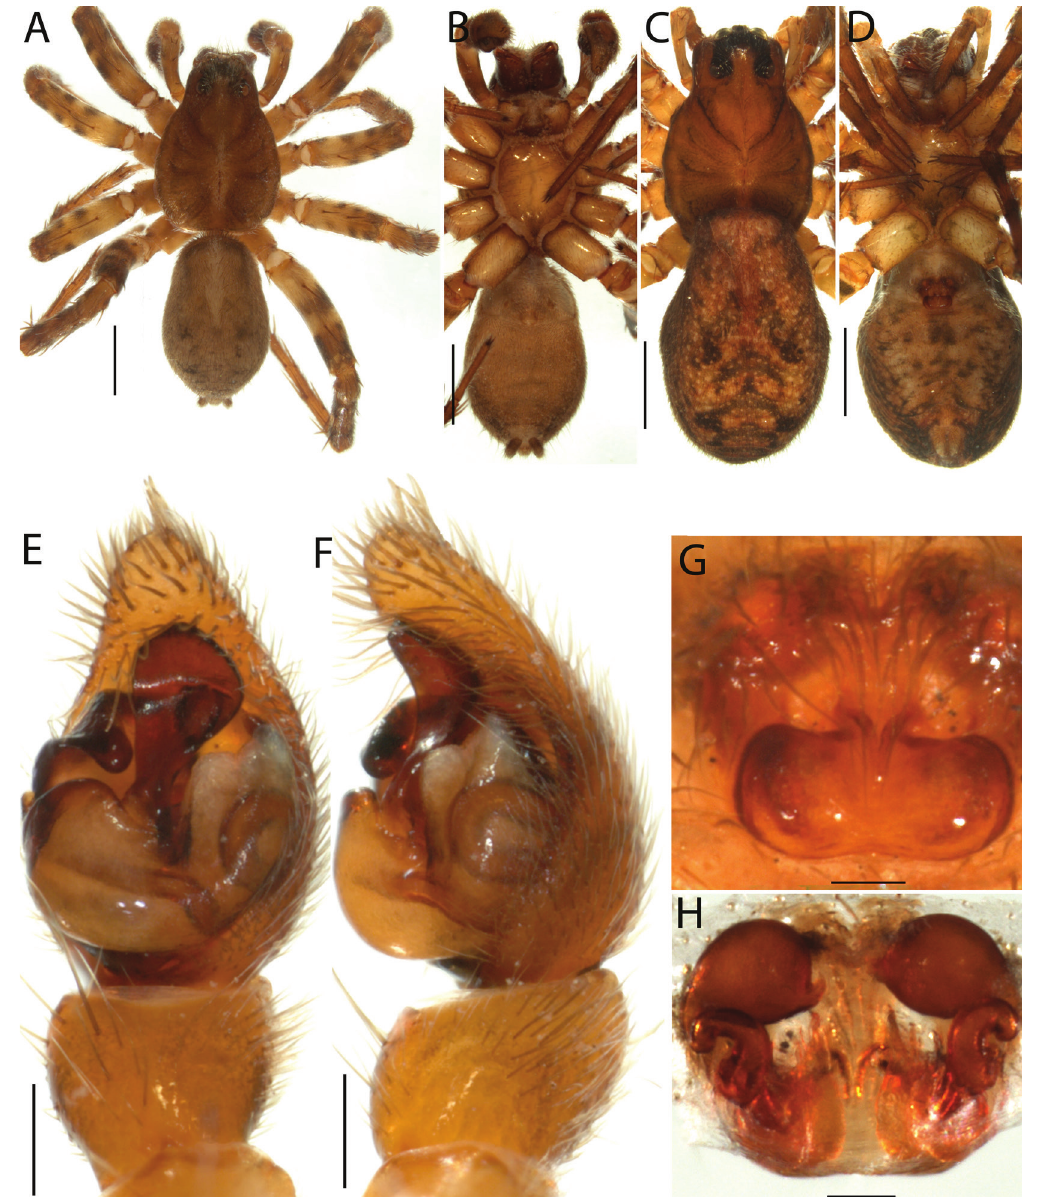
Figure 28. Artoria lineata (L. Koch, 1877), male and female (AM KS21673): A , male habitus, dorsal view; B , male habitus, ventral view; C , female habitus, dorsal view; D , female habitus, ventral view; E, male pedipalp, ventral view; F , male pedipalp, retrolateral view; G , epigyne, ventral view; H , epigyne, dorsal view. Scale bars: habitus 1.0 mm; pedipalp, epigyne 0.1